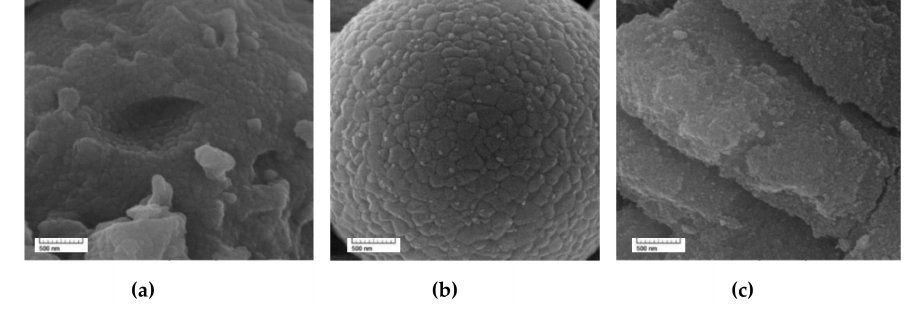
Figure 1. SEM image of ( a ) TiO 2 , ( b ) TS, and ( c ) TSFG.